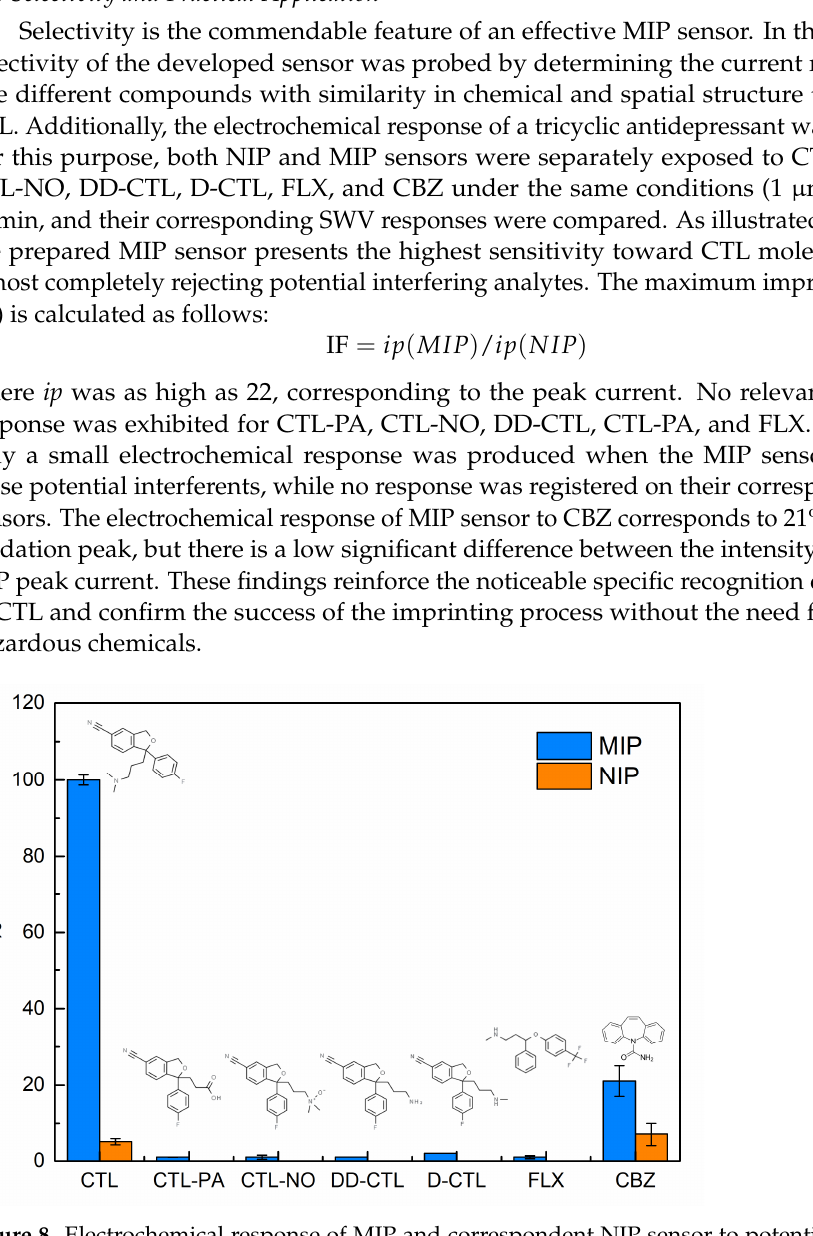
Figure 8. Electrochemical response of MIP and correspondent NIP sensor to potential interferent compounds with close structural similarities to CTL.